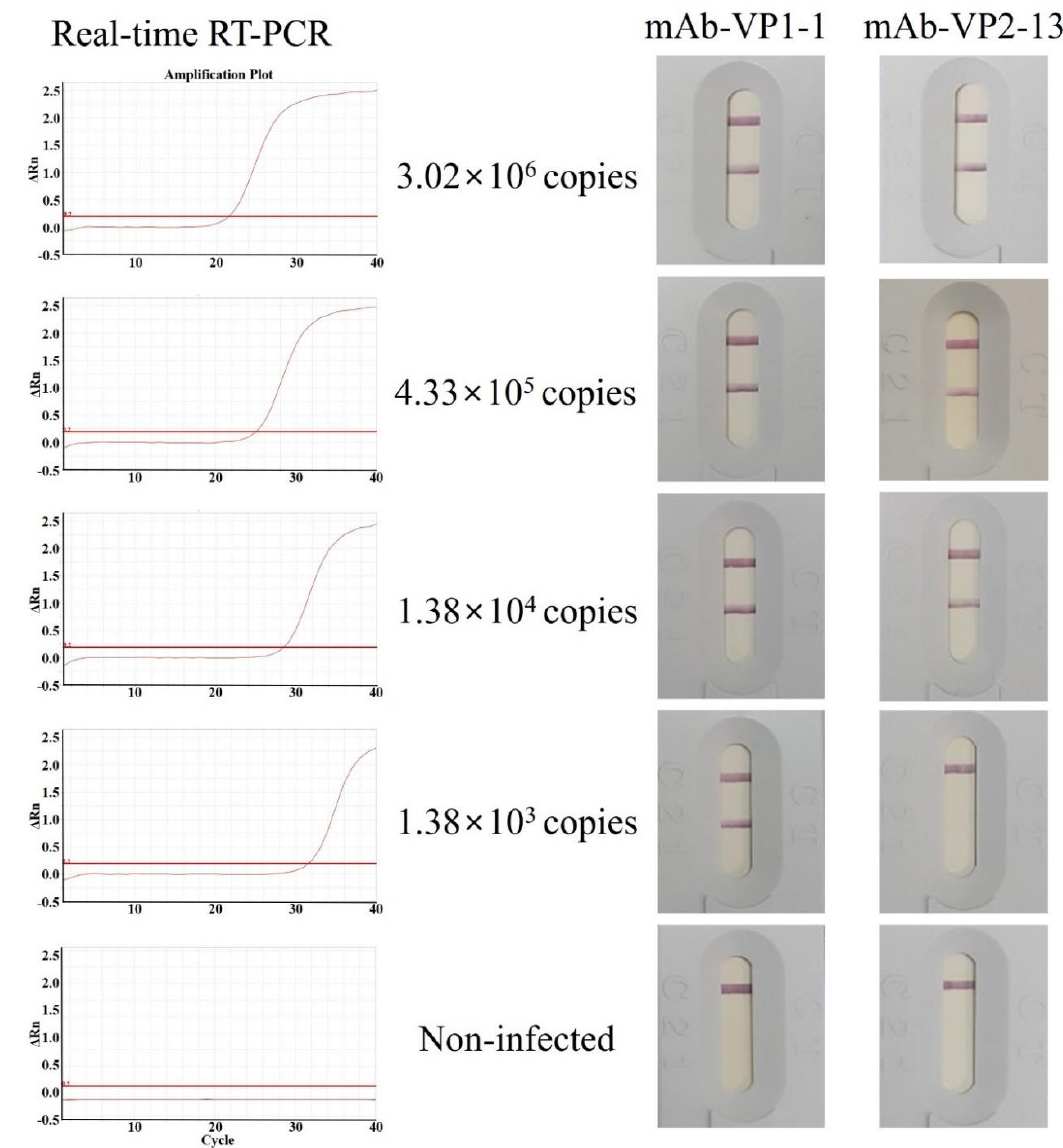
Figure 5. Detection limit of the IC assay with gold-conjugated VP1-specific and VP2-specific mAbs. The reference sample was serially diluted (10-fold) from 10 3 to 10 6 copies. Each diluted sample was amplified by real-time RT-qPCR and compared to standard curves in Figure S4. Table 1. Comparative evaluation of AcSBV-infected larva samples by real-time PCR and IC